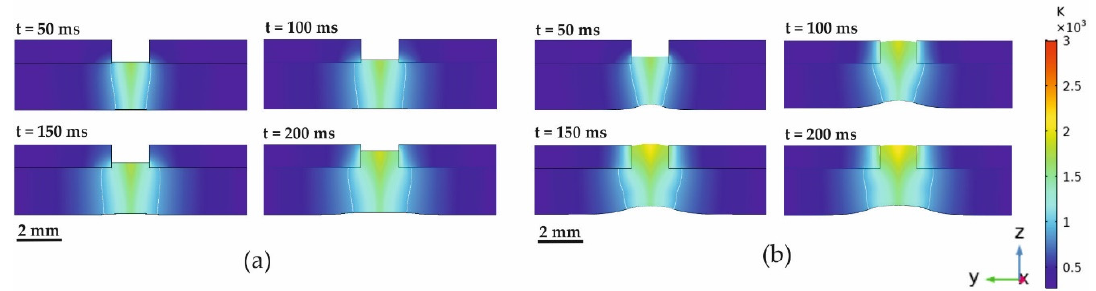
Figure 13. The development of the melt pool flows induced by the Lorentz forces for 1936 W shown with velocity vectors and the melting isotherm in the symmetry plane.